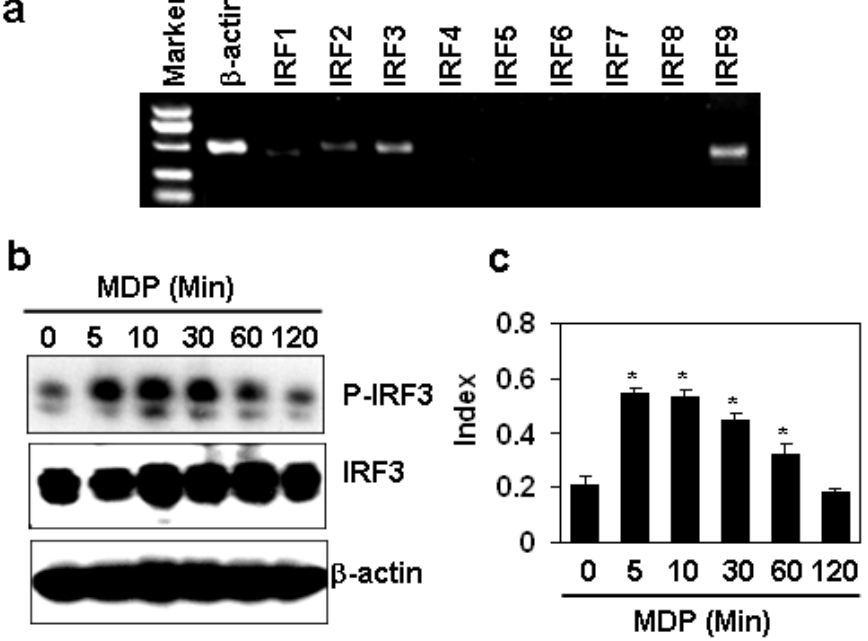
Figure 4. MDP induces the phosphorylation of IFR3 in HAECs. ( a ) The gene expression of IRFs in HAECs by RT-PCR; ( b ) The effect of MDP on the phosphorylation of IRF3. HAECs were treated with 10 µg/mL MDP for indicated minutes. The phosphorylated IRF3 was measured by Western blot. β -actin protein was measured as loading control; ( c ) The quantitation of protein levels of phophorylated IRF3 in ( b ). The levels of protein expression were semi-quantitated by scanning the pixel intensity of the bands of phophorylated IRF3 and normalized with the levels of total IRF3 proteins. * P < 0.05 compared with the control groups, n = 3 in each group.